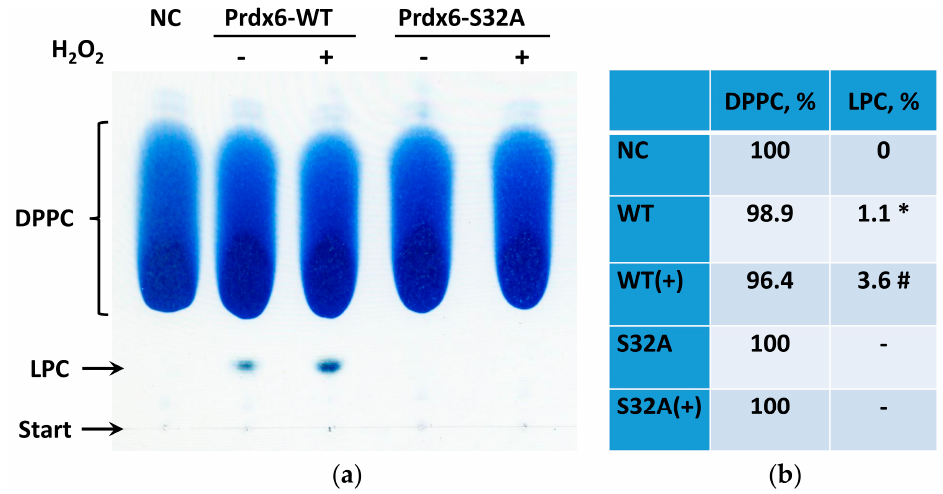
Figure 3. Phospholipase activity of the wild-type form (WT) and deficient for phospholipase active center mutant (S32A) of Prdx6. ( a ) The thin layer chromatography (TLC) of phospholipids following 1-h incubation at pH 5.0 with peroxiredoxins: dipalmitoylphosphatidylcholine (DPPC), lysophosphatidylcholine (LPC). TLC start point is marked on the silica gel plate; ( b ) Results of TLC densitometry (N = 3). * p < 0.01–changes are statistically significant relative to the negative control (NC); # p < 0.01 changes are statistically significant relative to the group with wild-type Prdx6 protein (WT).